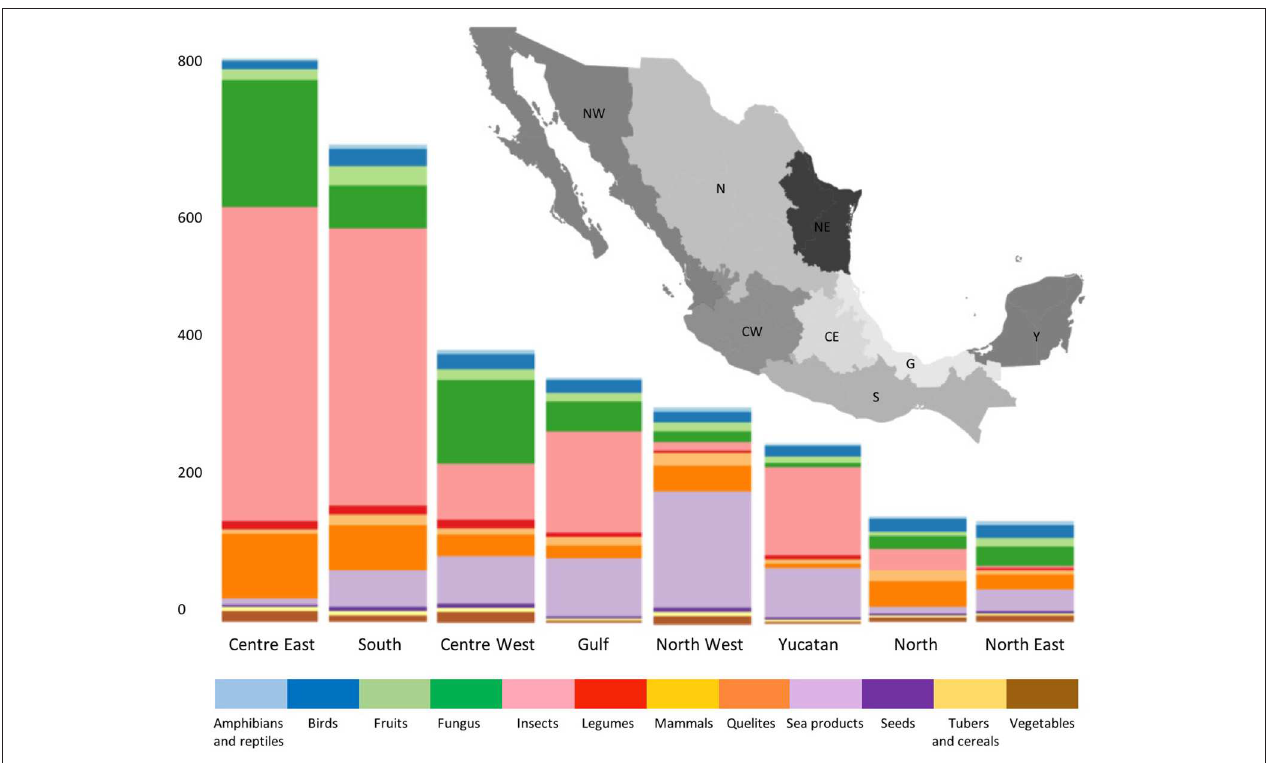
FIGURE 6 | Number of edible species per category at Mexican